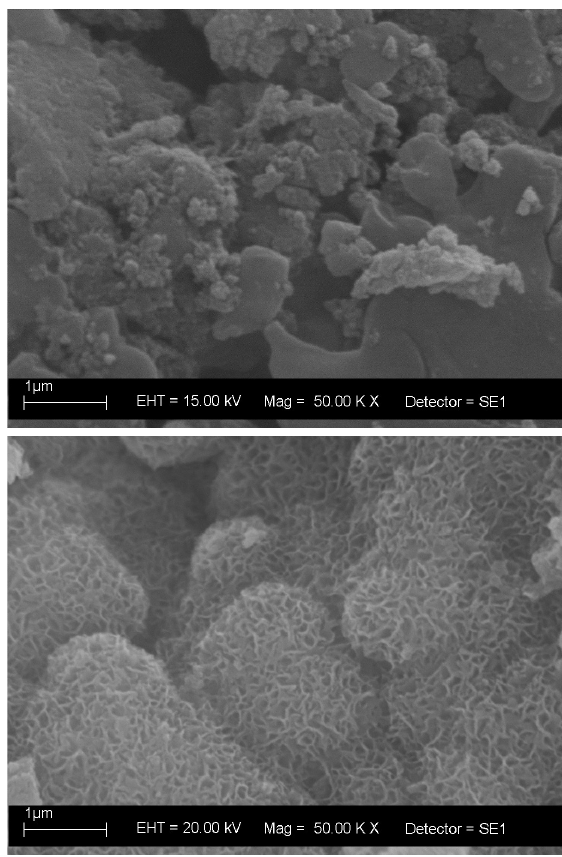
Figure 9 - SEM micrographs of the samples treated at (a) 110°C or (b) 900°C after contact with SBF for three